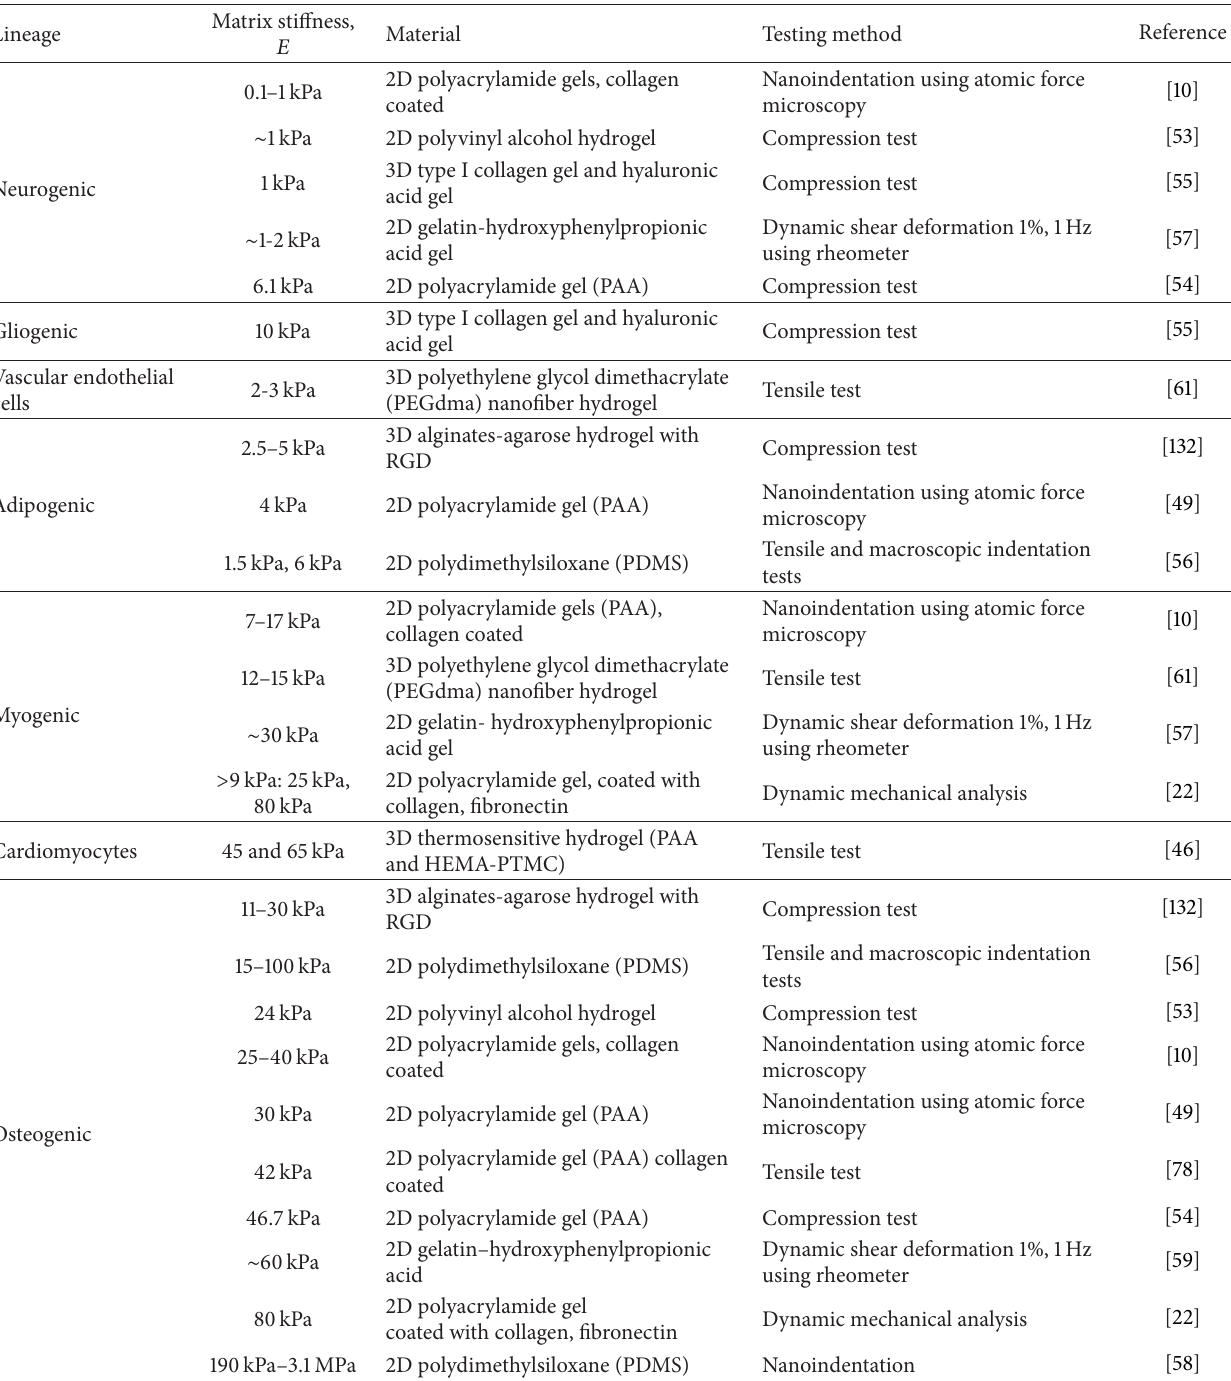
Table 4: Summary of MSC differentiation dependence on substrate